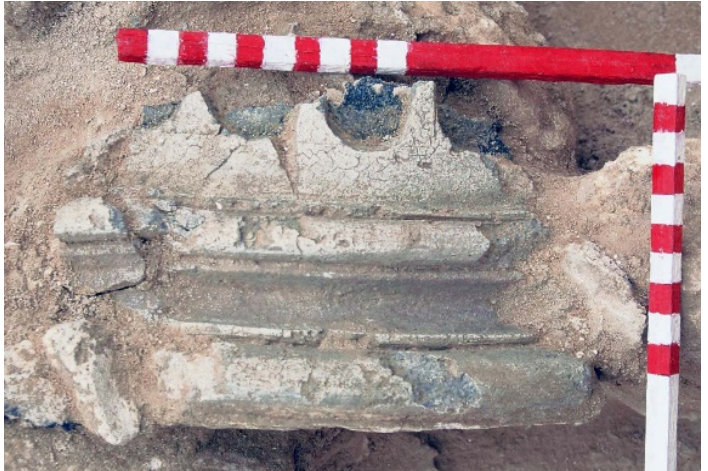
Figure 21. Fragment of attic base and shaft of half column from frame of aedicula found in house H10, assigned to the second phase, rendered in stuccowork (photo Rafał